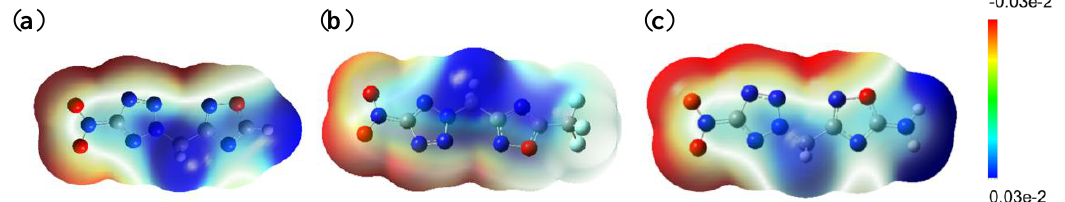
Figure 6. Electrostatic potential of NTOM ( a ), NTOF ( b ) and NTOA ( c ) (B3LYP//6-311g(d, p), 0.001 electron/b3 isosurface, energy values –0.03 to + 0.03 H). Color coding: yellow, slightly negative; green, neutral; turquoise, slightly positive; light blue, positive; dark blue, very positive.